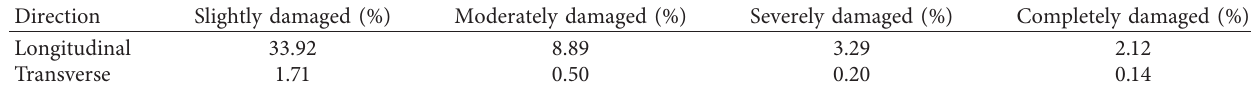
Table 8: Longitudinal and transverse risk probability of key sections of piers during the design reference period. Direction Slightly damaged (%) Moderately damaged (%) Severely damaged